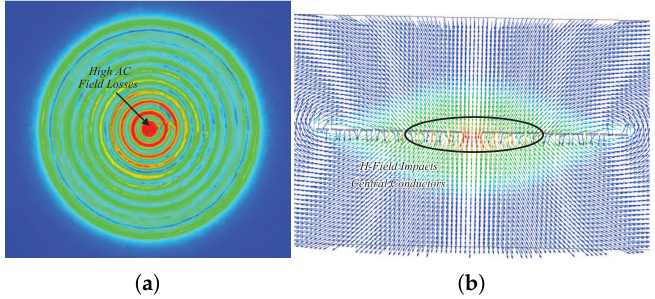
Figure 16. ( a ) Magnetic field strength, H , for a horizontal cross-section of a circular planar spiral winding. ( b ) Magnetic field intensity vector, ˜ H , for a vertical cross-section of a circular planar spiral winding